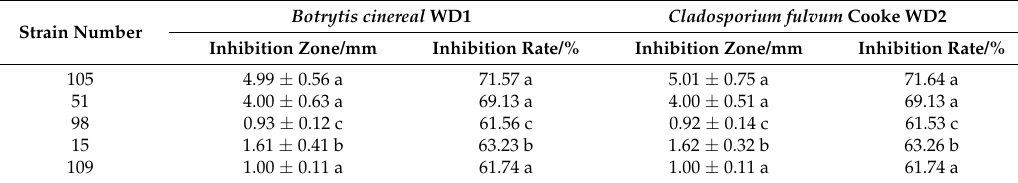
Table 1. Screening of biocontrol bacteria against tomato gray mold disease and tomato leaf mold disease.